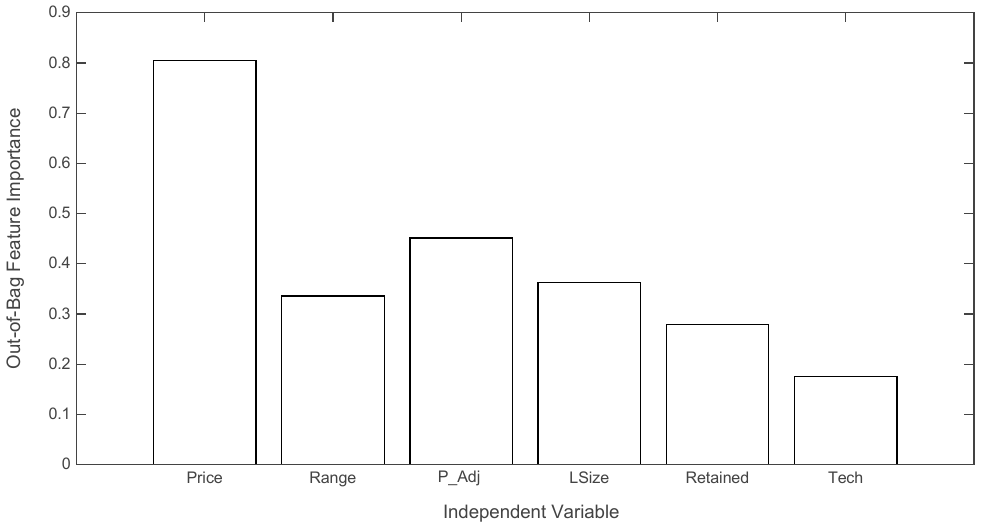
Figure 3. Out-of-bag independent variable importance measured by the standardized mean decrease in accuracy on the training set. Considered values are: width of price range (RANGE); offering price (PRICE); IPO price adjustment (P_ADJ); dummy variable representing whether the company operates in the technology sector (TECH); the size of the offering (LSIZE); and the proportion of the company retained by insiders (RETAINED).